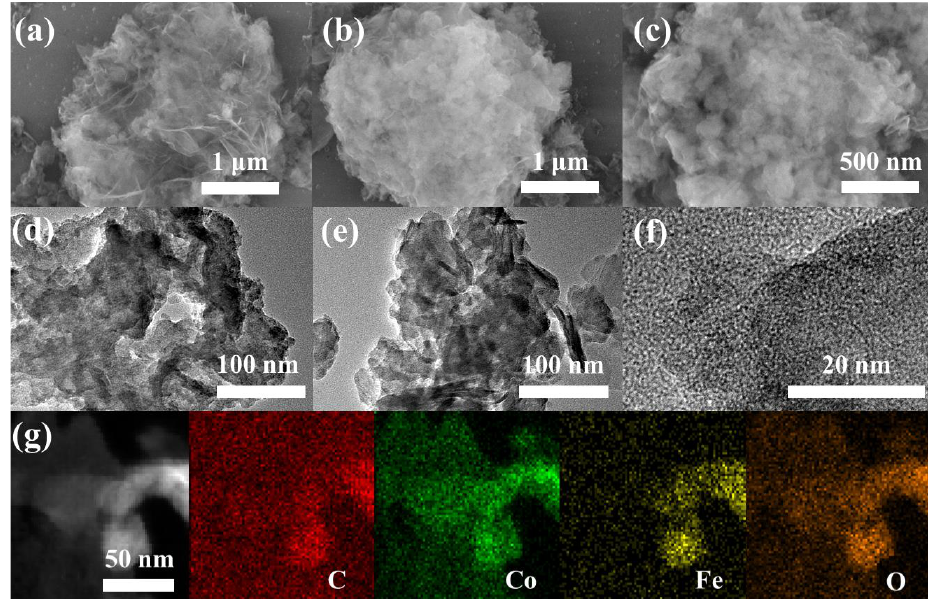
Figure 2. SEM images ( a – c ), TEM images ( d , e ), HRTEM images ( f ) and elemental mapping ( g ) of Co(OH) 2 @TA-Fe.